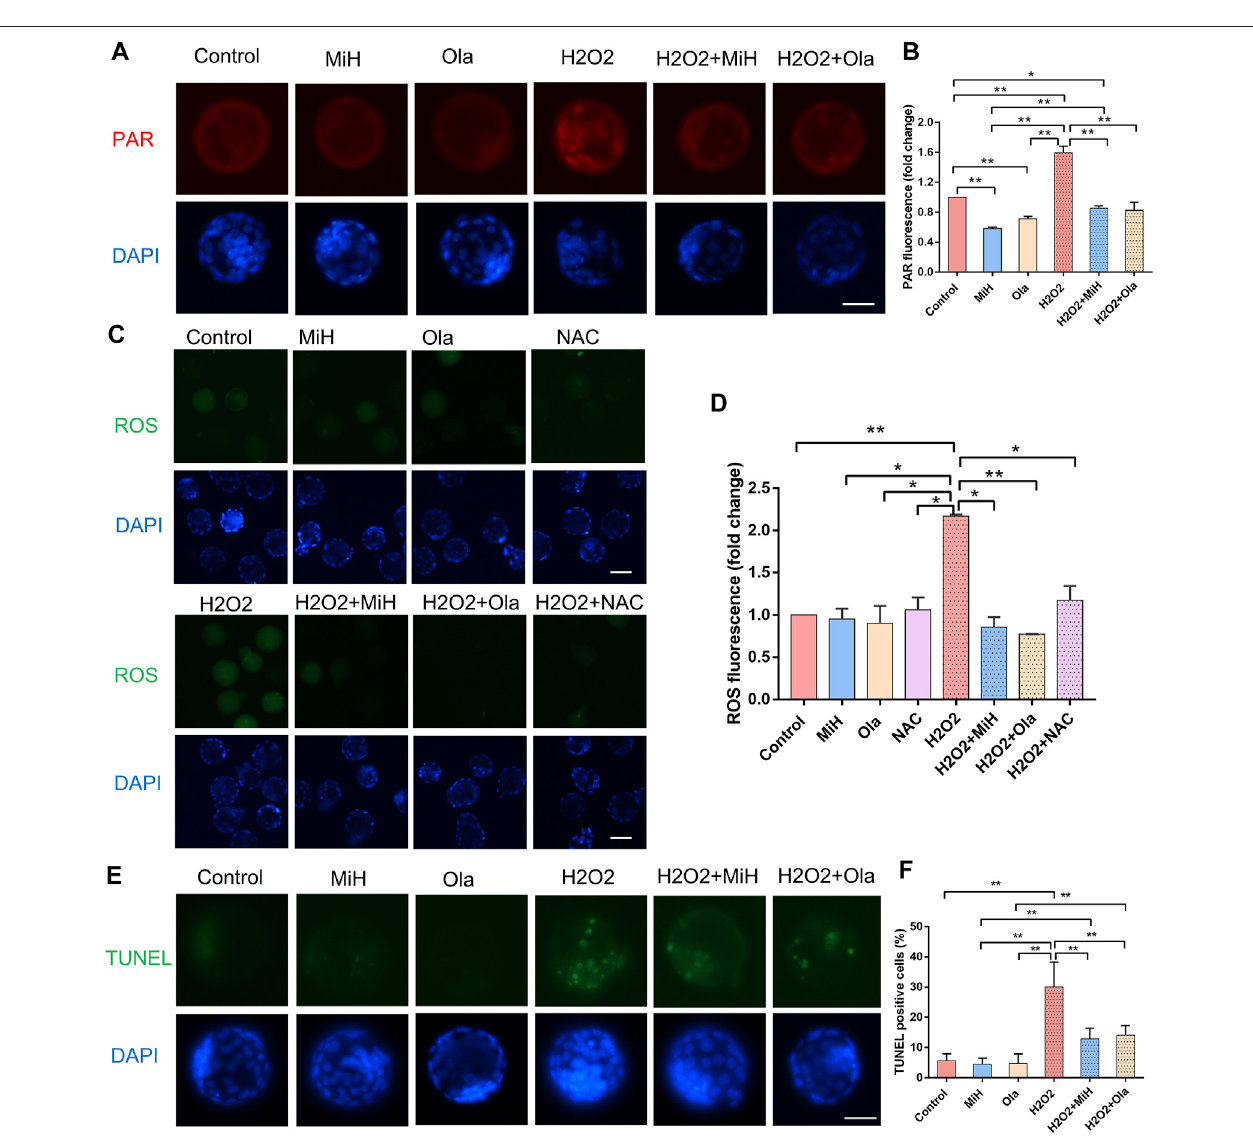
FIGURE 5 | PARP1 inhibitors could protect mouse embryos from ROS and reduced cell apoptosis. (A,B) Staining and intensity levels for PAR of expanded blastocysts in untreated and H2O2-treated groups supplemented MiH, Ola or not. (C,D) Fluorescent images and intensity levels of ROS in expanded blastocysts. (E,F) Representative fl uorescent images of apoptotic cells (E) and quantitative analysis of TUNEL-positive blastocysts (F) . Data are presented as mean ± SD in three independent experiments and student ’ s t tests are used for statistical analysis. p 0.01 < p < 0.05; pp p < 0.01; no labeling indicates no statistical signi fi cance. Bars (cid:1) 50 μ